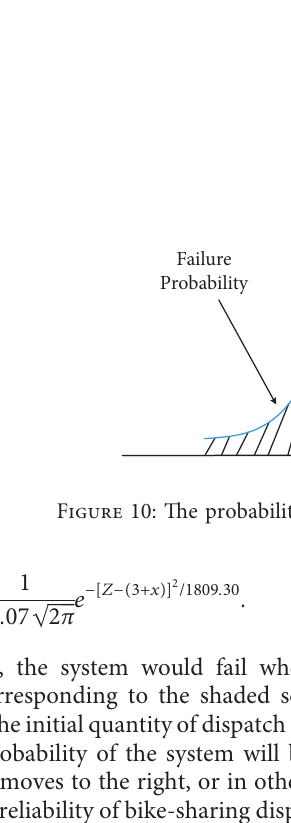
Figure 9: Selected dispatch points and areas for demonstrating the modeling process.